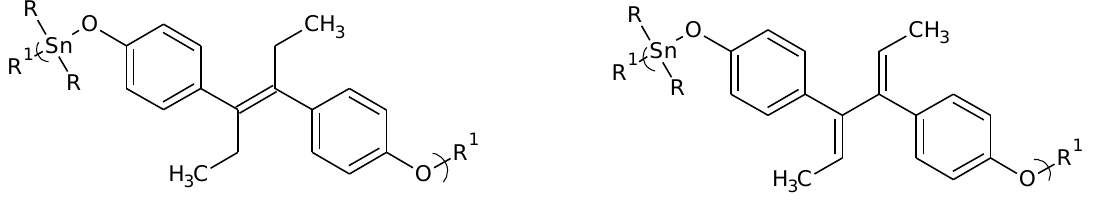
Figure 3. Repeat unit for organotin polymers from the reaction of organotin dihalides with diethylstilbestrol (DES), left, and with dienestrol, right. CH